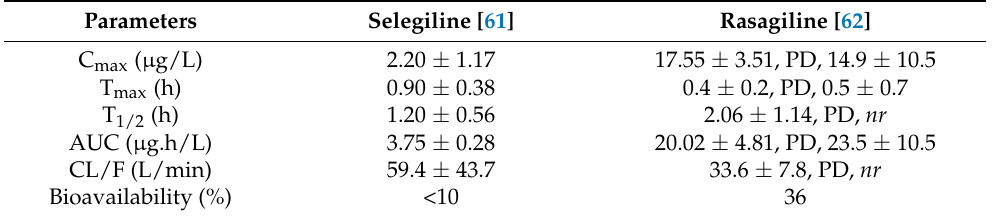
Table 1. Pharmacokinetic data of selegiline and rasagiline.